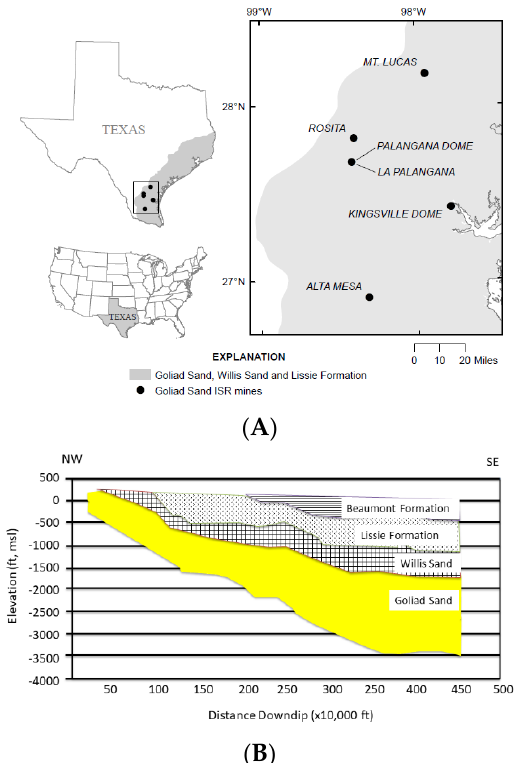
Figure 1. ( A ) Plan-view map of the Texas Coastal Plain with the six ISR operations completed in the Goliad Sand examined in this study in relation to the state of Texas and the United States region and ( B ) a cross-section map showing the uranium-rich Goliad Sand (modified from Young and others, 2006 [1]), indicated by the solid (yellow) shade.